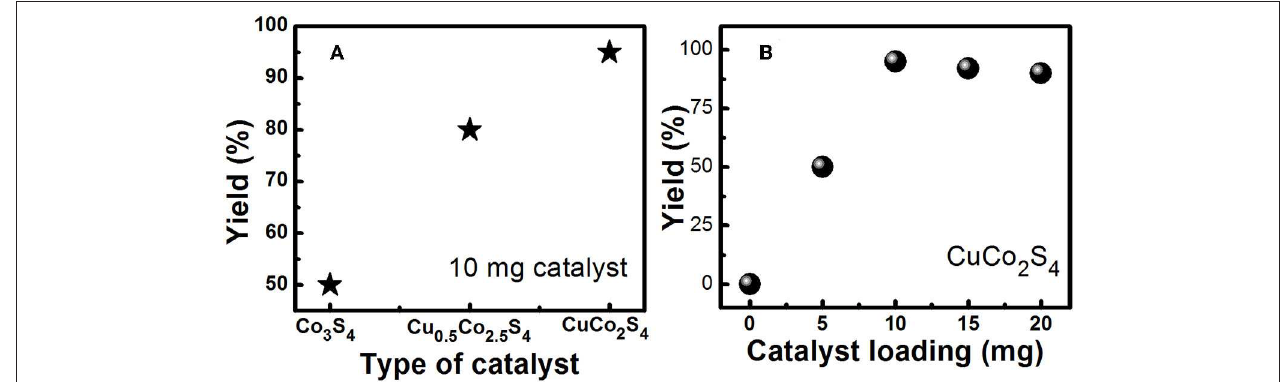
FIGURE 3 | (A) Optimization study for variation of catalyst (10mg catalyst, 2 mmol K 2 CO 3 , 5ml solvent, 180min, 25 ◦ C). (B) Optimization study for variation of catalyst loading